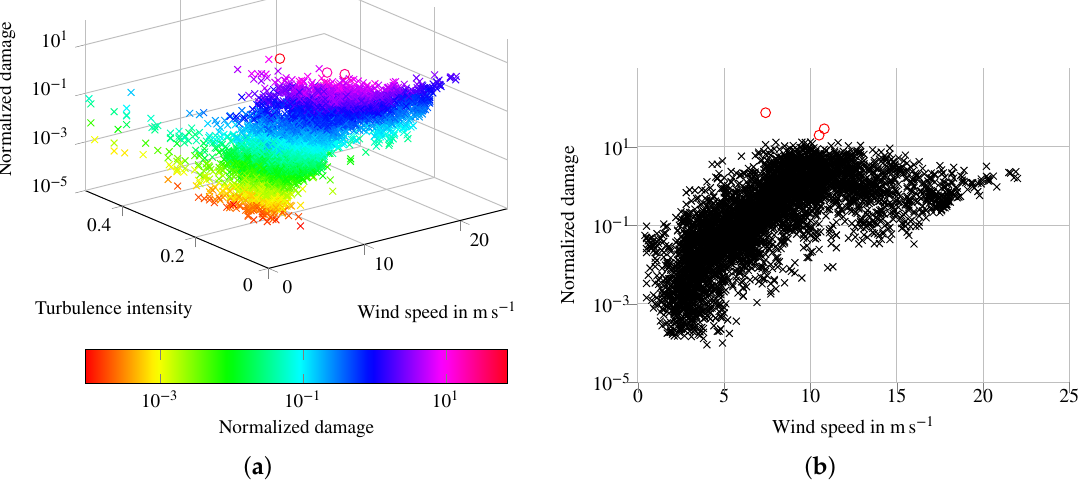
Figure 5. Investigation of the reasons for high uncertainty. ( a ) Scatter plot showing damages depending on wind speed and turbulence intensity (representative 1-month measurement data of D06). “Outliers” are marked with circles. ( b ) Scatter plot showing damages depending on the wind speed (representative 1-month measurement data of D06). “Outliers” are marked with circles.